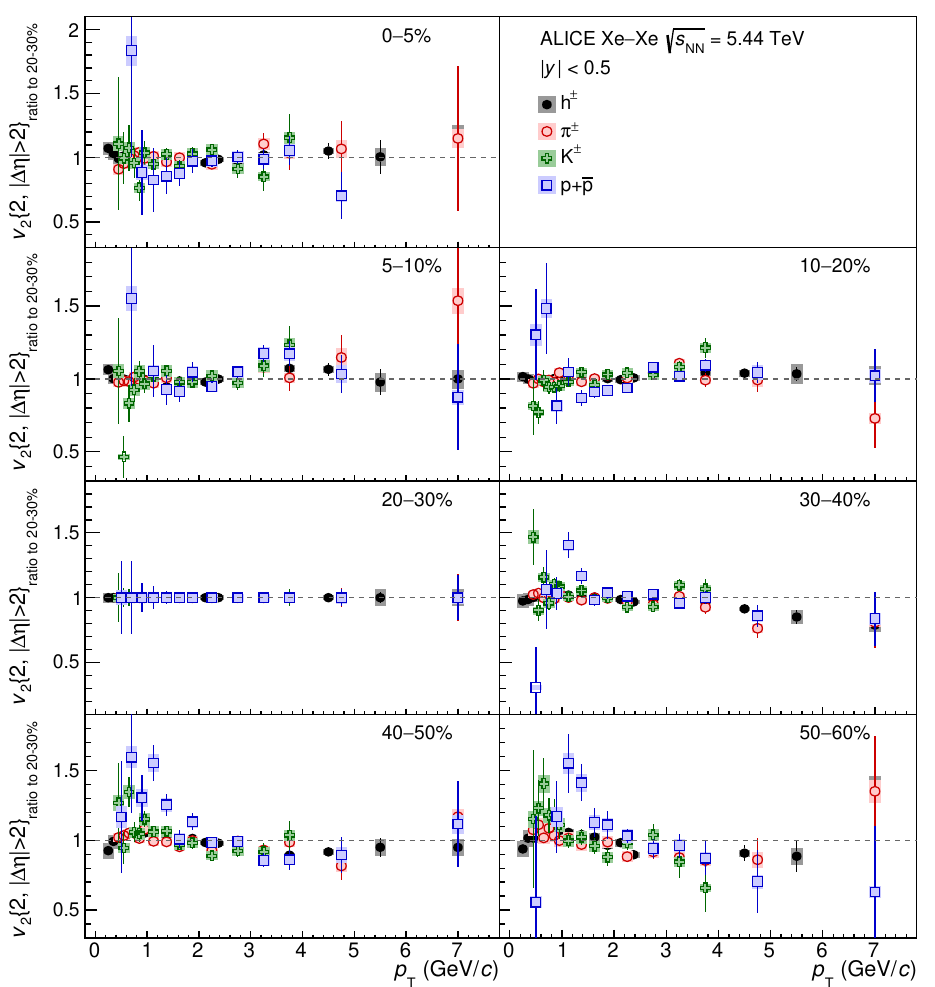
Figure 8. Centrality dependence of v 2 ( p T ) hadrons (h ± ) [22]. Bars (boxes) denote statistical (systematic)